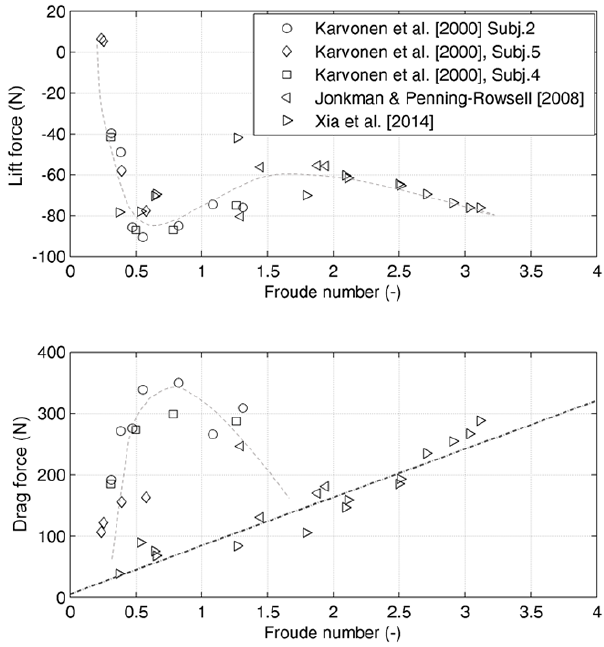
Figure 5. Estimated lift (top panel) and drag (bottom panel) forces versus the relative submergence for the four human subjects (Kar- vonen et al., 2000; Jonkman and Penning-Rowsell, 2008) and the human-scale model (Xia et al.,